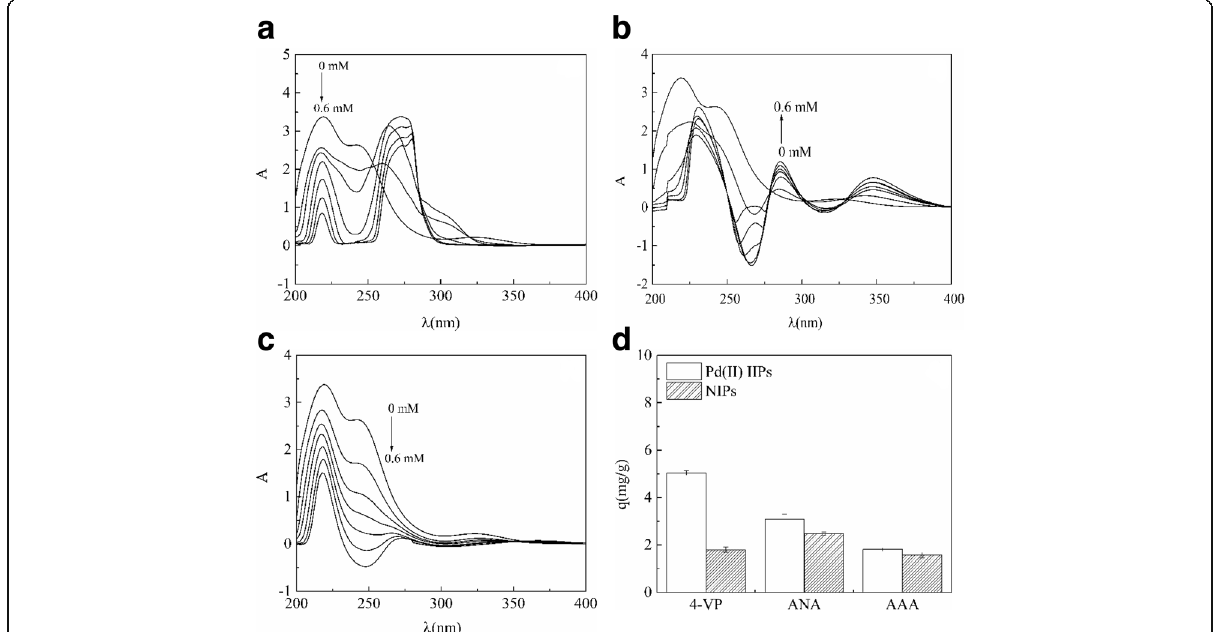
Fig. 1 Ultraviolet spectra of the interactions between PdCl 42 − and ( a ) 4-VP, ( b ) ANA, ( c ) AAA in methanol and ( d ) adsorption properties of Pd(II) IIPs synthesized by different function